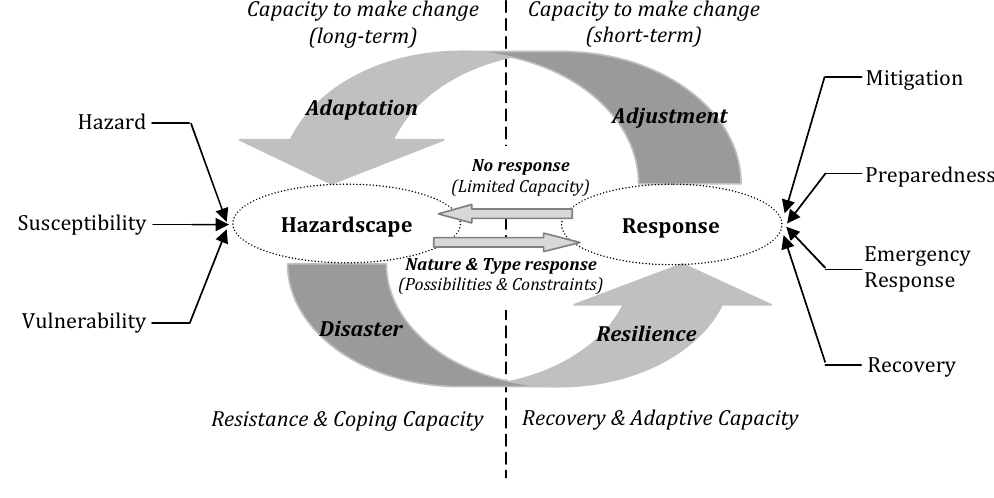
Fig 3 Relationship between hazardscape and response Fig. 3. Relationship between hazardscape and